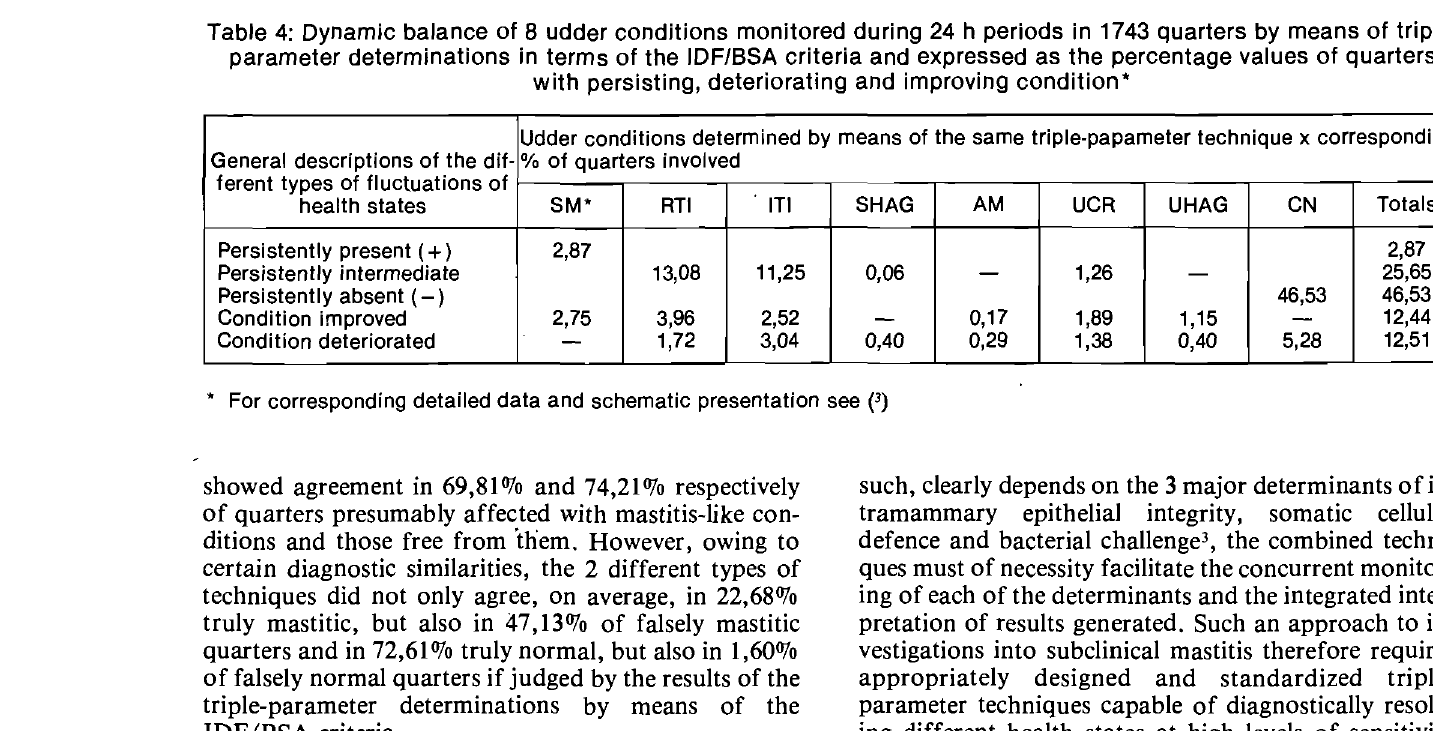
Table 4: Dynamic balance of 8 udder conditions monitored during 24 h periods in 1743 quarters by means of triple parameter determinations in terms of the IDF/BSA criteria and expressed as the percentage values of quarters with persisting, deteriorating and improving condition" Udder conditions determined by means of the same triple-papameter technique x corresponding General descriptions of the dif- % of quarters involved ferent types of fluctuations of . ITI SHAG AM UCR UHAG CN Totals health states SM" RTI PerSistently present ( + )